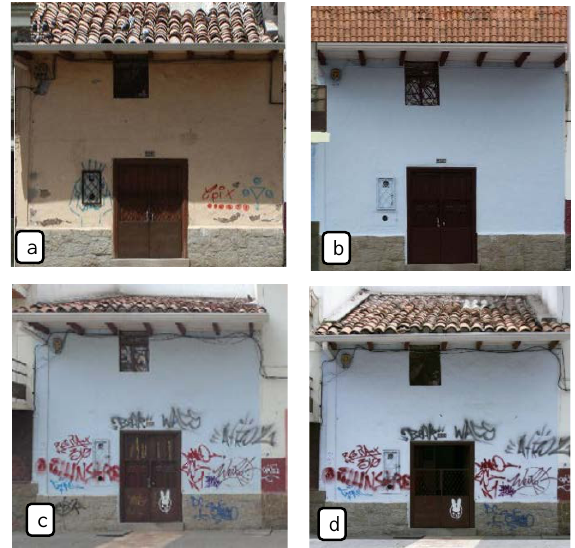
Figure 2a: The condition of the buildings in the Diagnosis phase, before the Campaign (2012). Source: vlirCPM project.